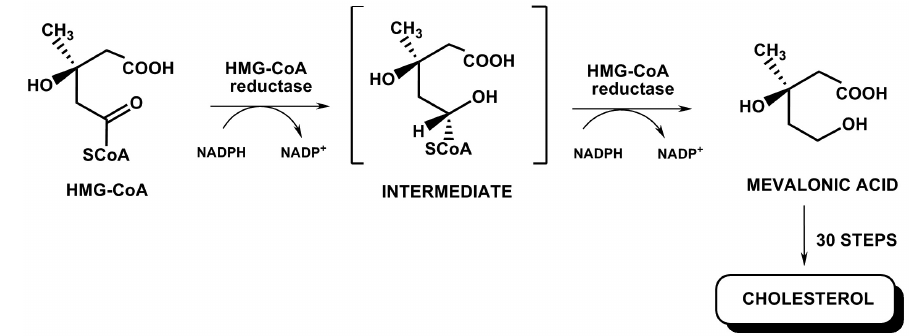
FIGURE 7 - The cholesterol biosynthetic pathway of HMGCo-A (hydroxy-methylglutaryl-Coenzyme A).